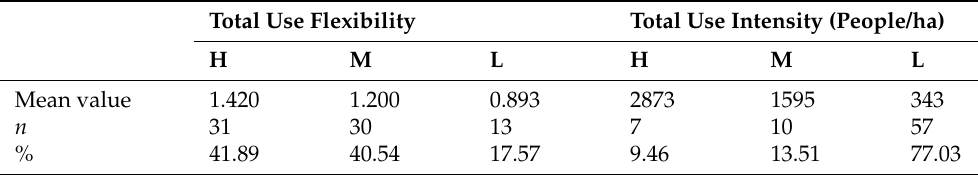
Table 6. Results of k-means clustering according to total use flexibility and total use intensity.